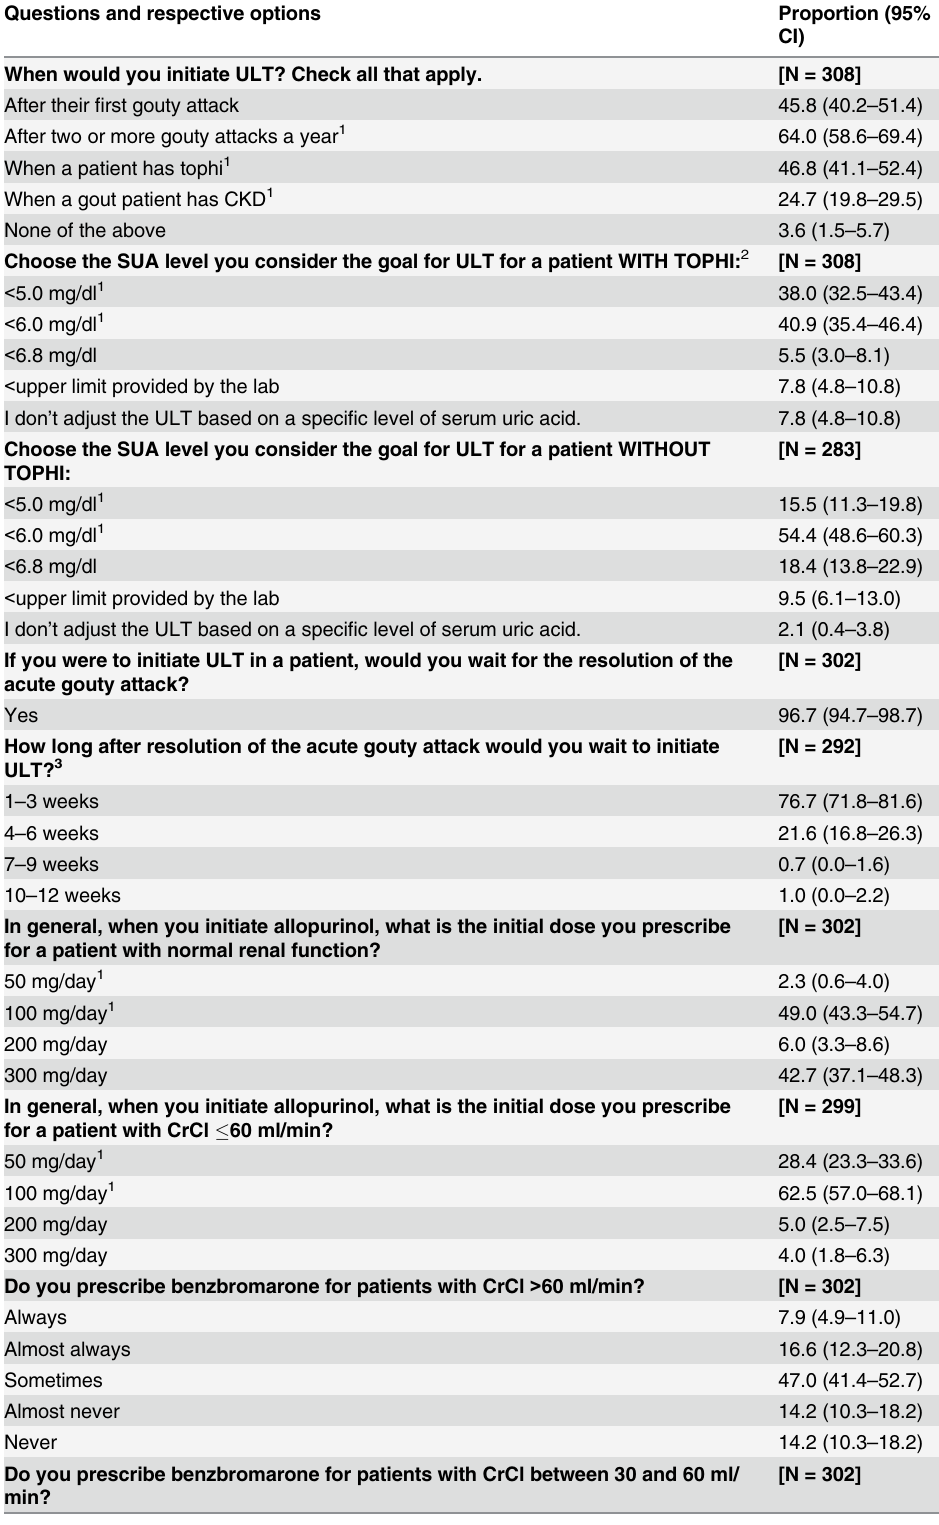
Table 5. Urate-lowering therapy